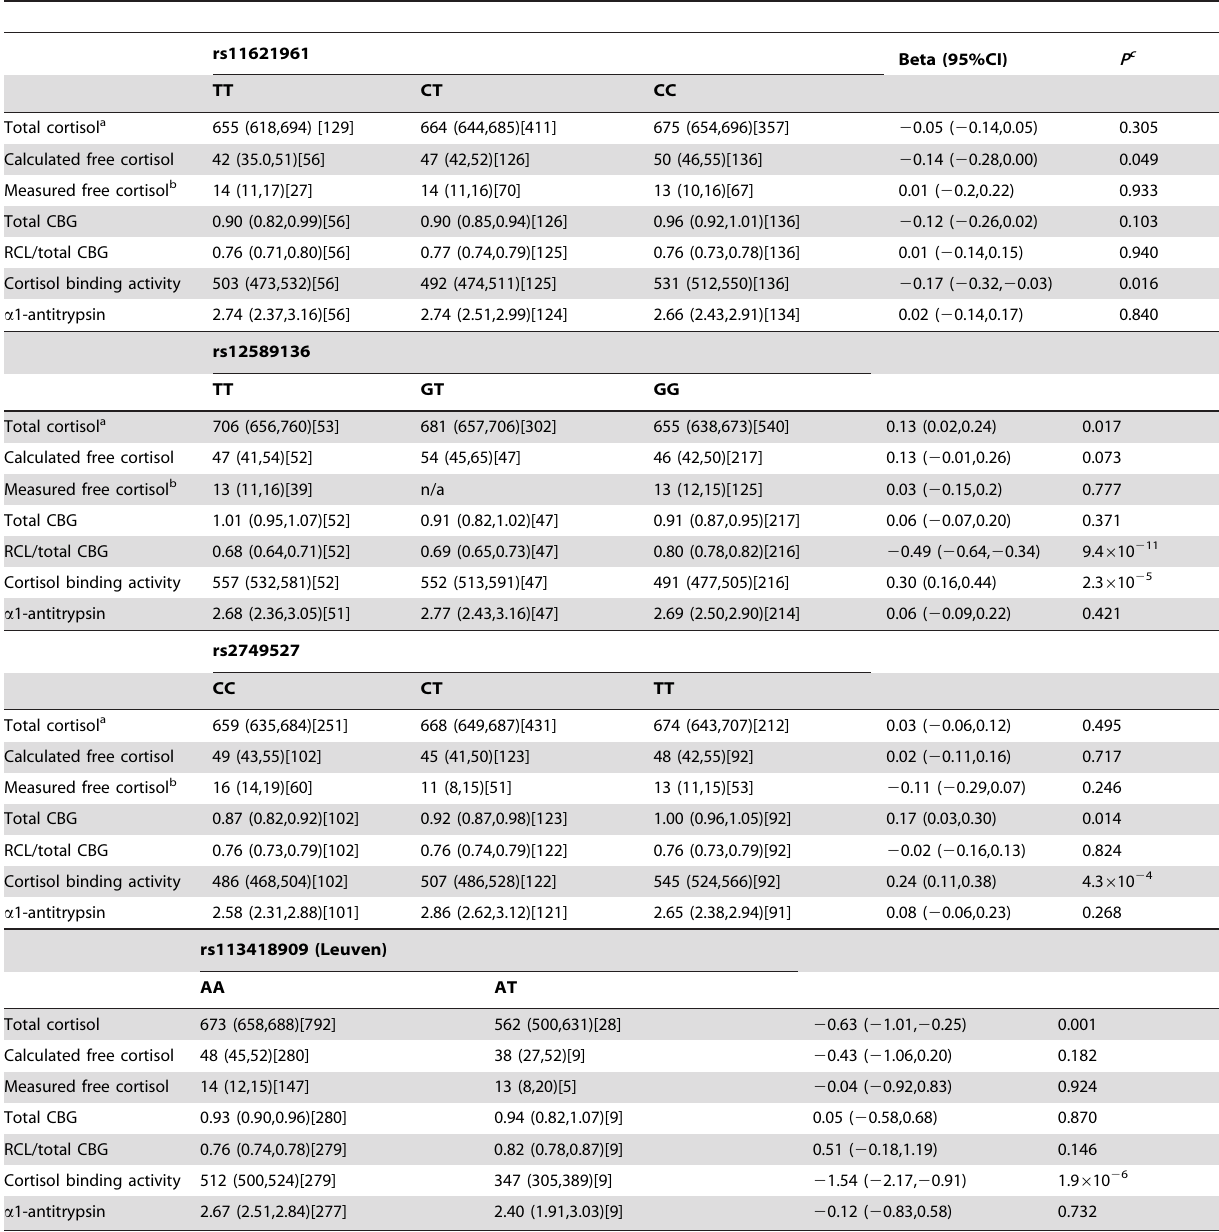
Table 2. Functional consequences of variants in the SERPINA6/A1 locus significantly associated with morning plasma cortisol in GWAMA, and of the Leuven variant, in